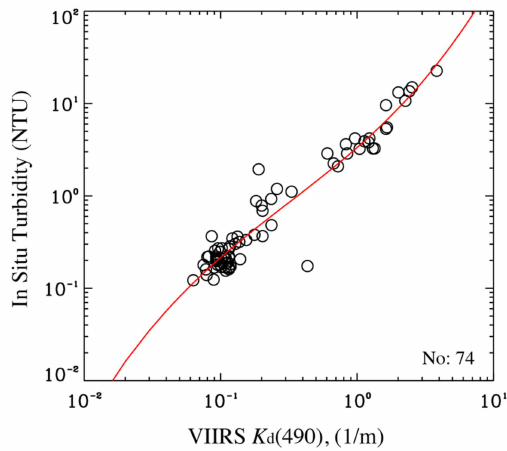
Figure 2. In situ-measured water turbidity (NTU) as a function of VIIRS–Suomi National Polar-orbiting Partnership (SNPP)-derived K d (490) for the Great Lakes.